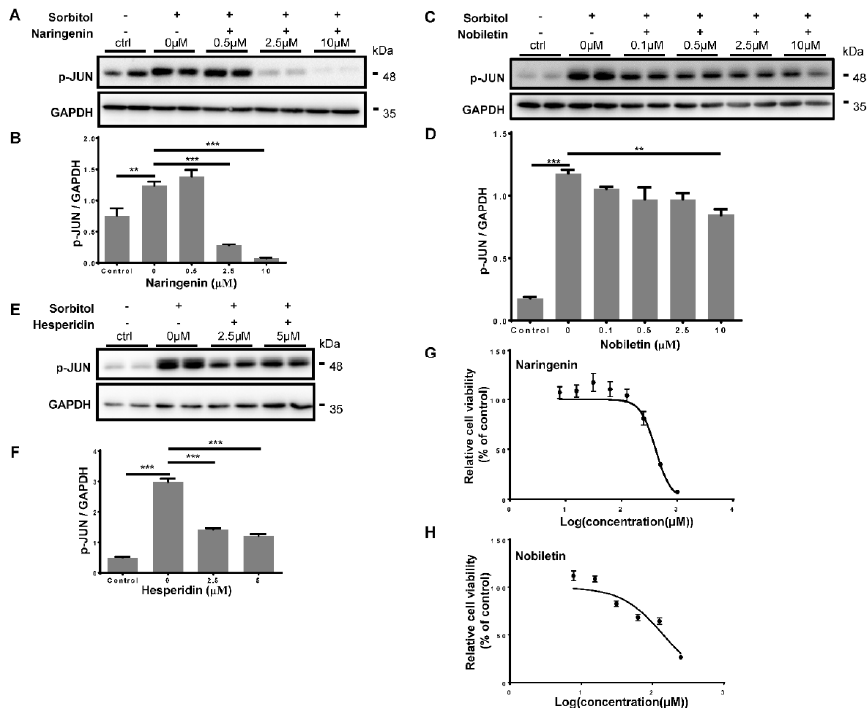
Figure 2. Inhibition of stress-induced pro-apoptotic JNK-JUN pathway by citrus components in HEK293T cells. ( A ) Western blot results of treatments of different concentrations of naringenin, after pre-incubation with sorbitol to activate the JNK-JUN pathway in HEK293T cells. ( B ) Statistical analysis of phosphorylation level of JUN relative to GAPDH loading control after treatments of different concentrations of naringenin. ( C ) Western blot results of treatments of different concentrations of nobiletin, after pre-incubation with sorbitol to activate the JNK-JUN pathway in HEK293T cells. ( D ) Statistical analysis of phosphorylation level of JUN relative to GAPDH loading control after treatments of different concentrations of nobiletin. ( E ) Western blot results of treatments of different concentrations of hesperidin, after pre-incubation with sorbitol to activate JNK-JUN pathway in HEK293T cells. ( F ) Statistical analysis of phosphorylation level of JUN relative to GAPDH loading control after treatments of different concentrations of hesperidin. Rabbit anti-phospho-JUN antibody was used to detect JUN phosphorylation. Mouse anti-GAPDH antibody was used to detect loading control-GAPDH. Data are represented as mean ± SEM of 4 replicates; ** p < 0.01; *** p < 0.001. ( G ) Relative cell viability analysis of naringenin in HEK 293T cells. ( H ) Relative cell viability analysis of nobiletin in HEK 293T cells. Each point is represented as mean ± SEM of 6